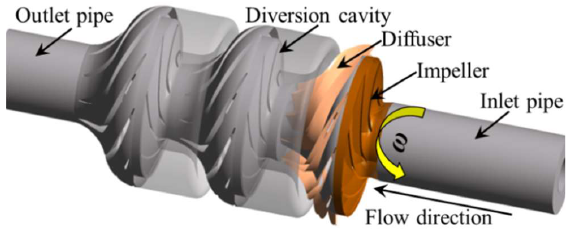
Figure 2. The CFD computational domain.